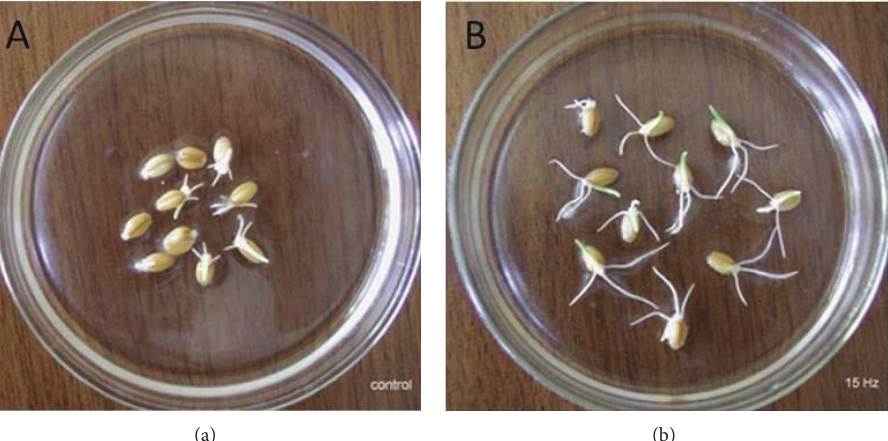
Figure 4: Barley seeds germination at the end of 72 hours, which were 15 minutes preincubated in Sham (control) (a) and 15Hz MV treated (b) DW.